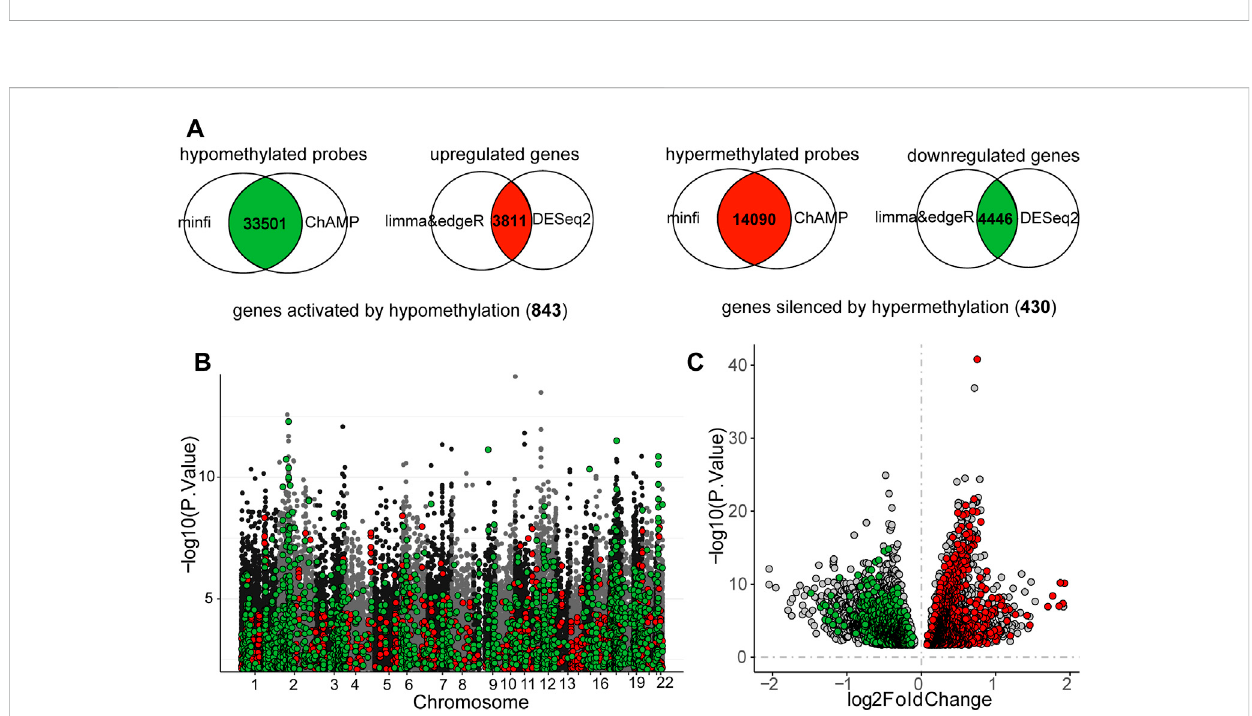
FIGURE 4 Intersection of the differentially expressed genes (DEGs) and different methylation probes (DMPs) to identify the DNA methylation regulated MSI- related genes. (A) Process of recognizing DEGs and DMPs. (B) Distribution of DNA methylation on chromosomes. MSI-related genes which were regulatedbyDNAmethylationwerehighlighted.RedpointsrepresentedprobesthatwerehypermethylatedinMSI-H,whereasgreenpointsindicatedthe probes were hypomethylated in MSI-H. (C) Volcano plot of DEGs between MSI-H and MSI-L groups. MSI-related genes which were regulated by DNA methylation were highlighted. Red points represented the upregulated MSI genes, and the green points represented the downregulated genes. Threshold of DEGs and DMPs was de fi ned as: |logFC| > 0 and p -value <